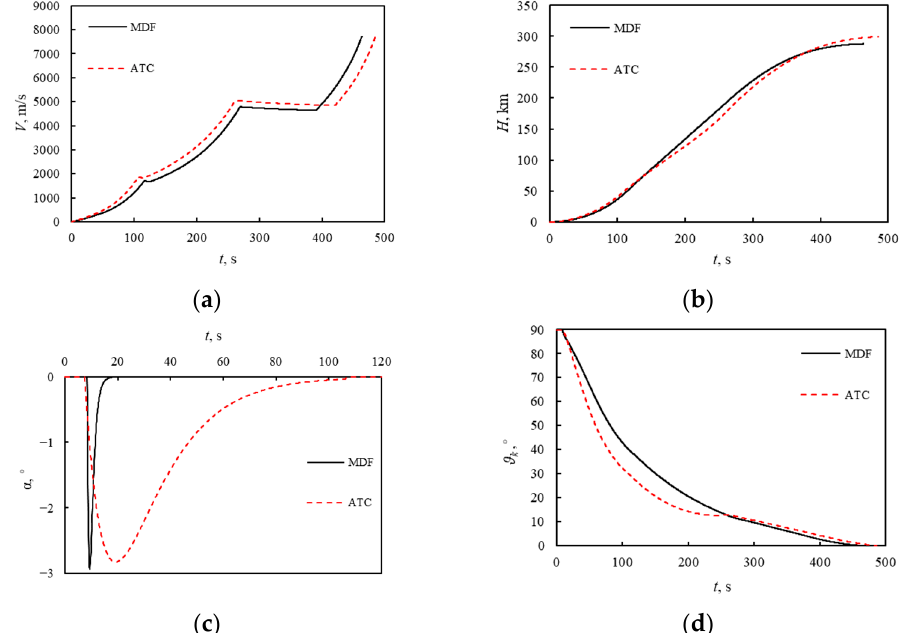
Figure 14. Scheme trajectory curves: ( a ) Actual velocity; ( b ) Actual flight altitude; ( c ) Attack angle in program turn phase; ( d ) Tilt angle.